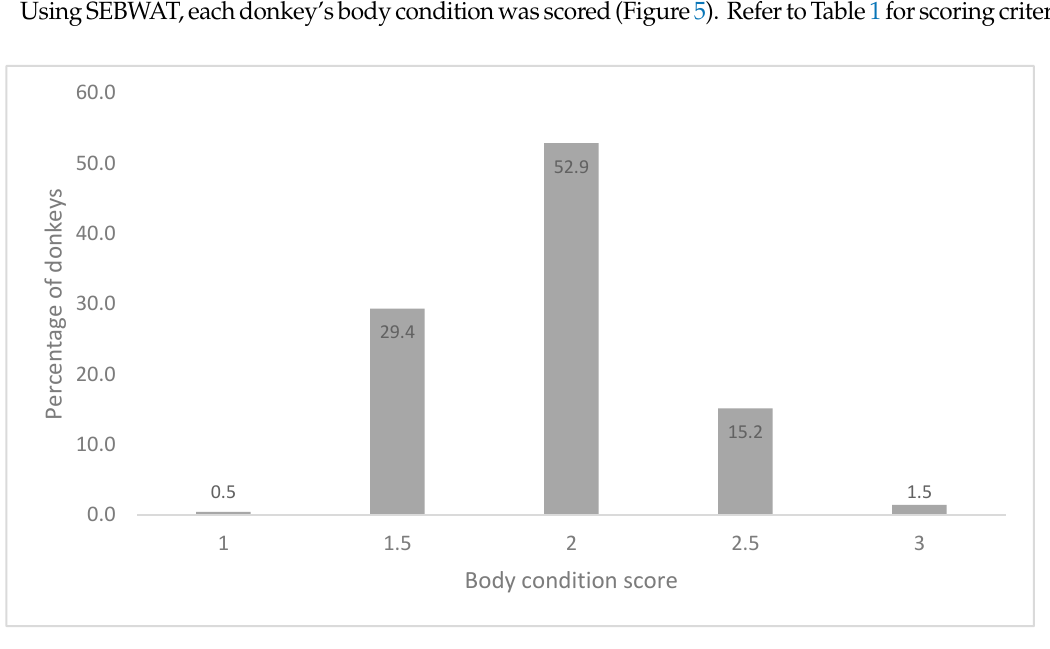
Table 4. Number of donkeys suffering from superficial and open lesions. Deep lesions were not reported.